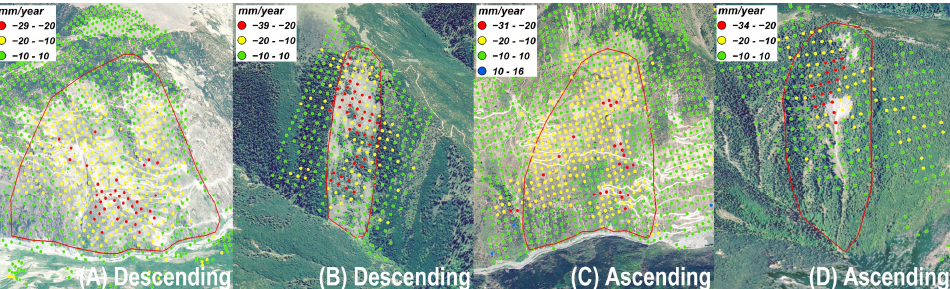
Figure 6. LOS velocity of typical slow-sliding rockslides. The base map is the Tianditu images with a spatial resolution of 1 meter. The red line represents the boundary of slow-sliding rockslides.